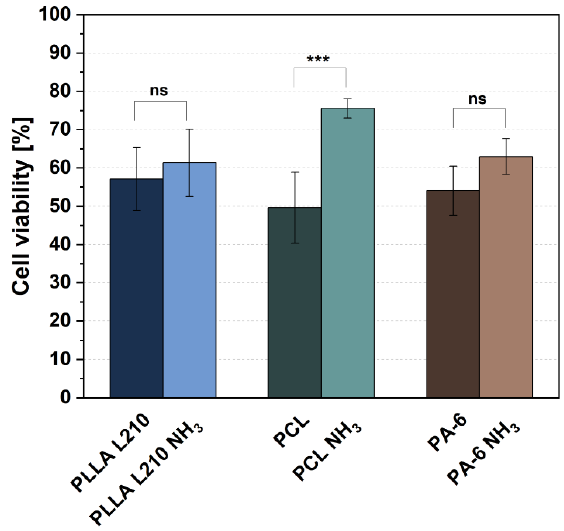
Figure 6. Relative viability of human endothelial EA.hy926 cells on unmodified and NH 3 -plasma functionalized polymeric nonwovens after 48 h (mean + SD, n = 6, one-way ANOVA, ns = not significant, and *** p < 0.001).